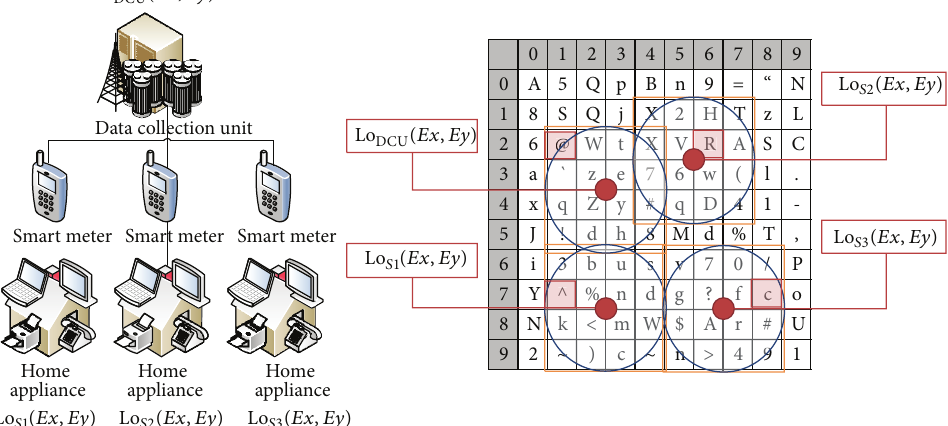
Figure 7: Selection of group key generation